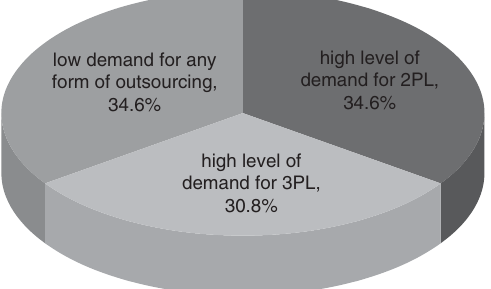
low demand for any form of outsourcing,